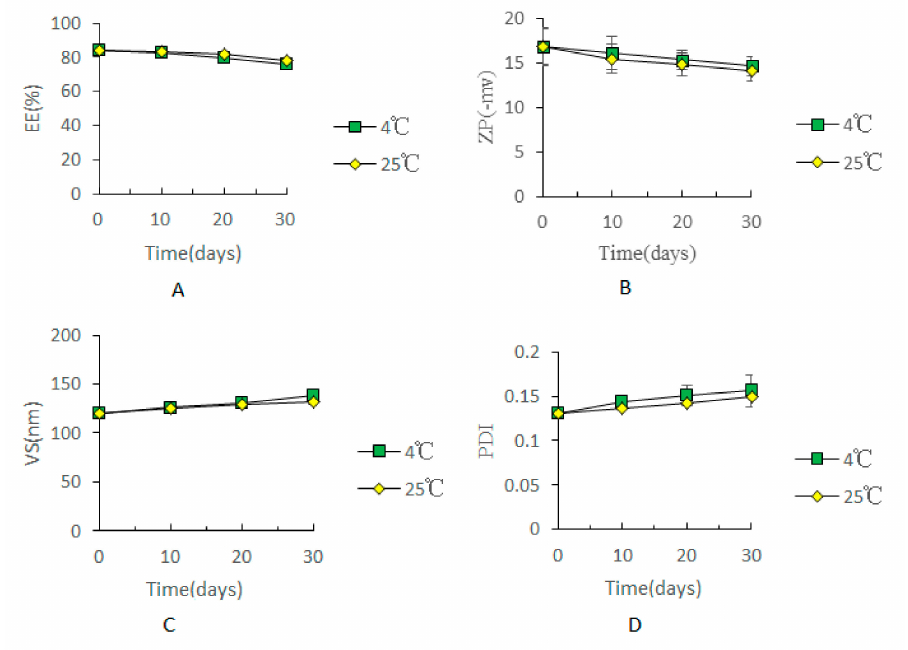
Figure 9. The effect on EE ( A ), ZP ( B ), VS ( C ) and PDI ( D ) stored at different temperatures: 4 ± 1 ◦ C and 25 ± 1 ◦ C for 30 days ( n =